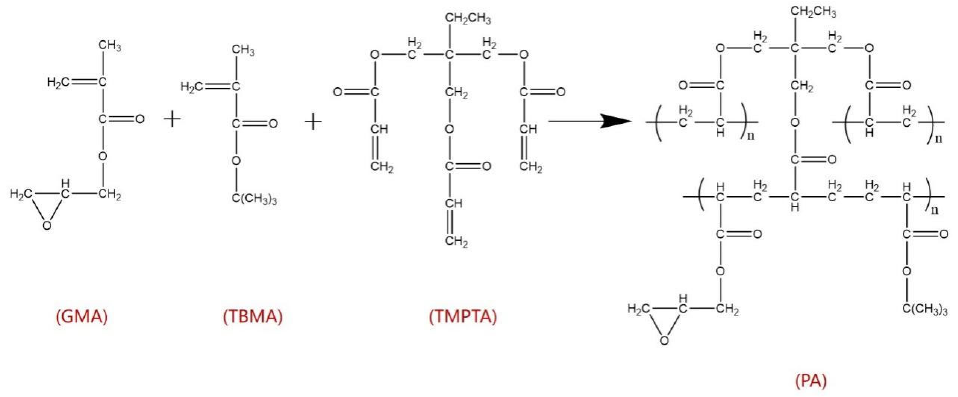
Figure 10. The reaction process to synthesize PA.